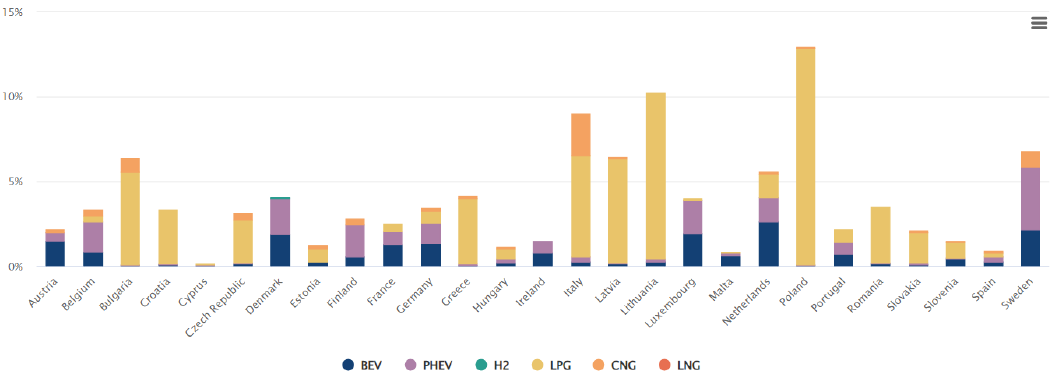
Figure 1. Alternative Fuel passenger cars and vans fleet (BEV, PHEV, H2, LPG, CNG, LNG) as % of total passenger cars and vans fleet in EU-27 during 2021; from [1].